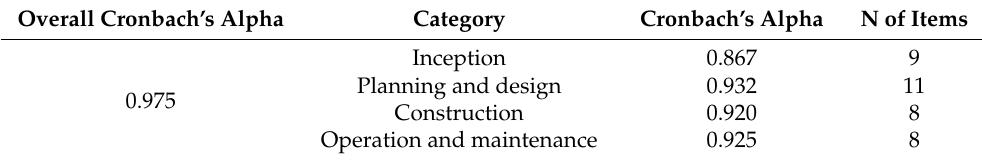
Table 4. Reliability analysis of CSFs.